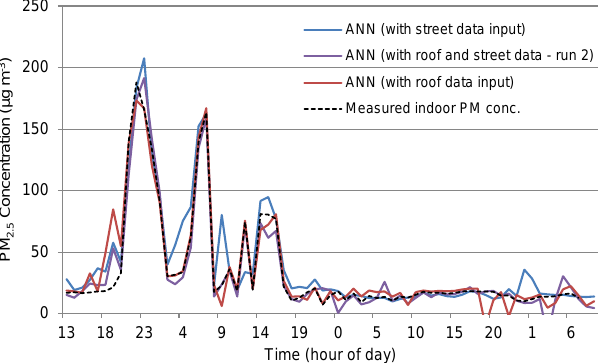
Figure 5. Time series of ANN trained versus measured indoor concentrations at M c 3 (run 2).